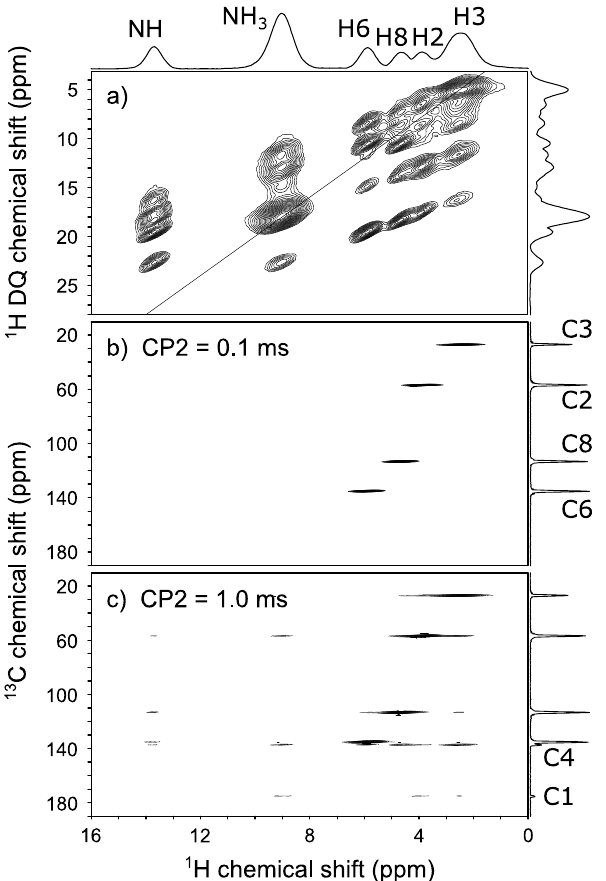
Figure 3. 1 H and 13 C spectral assignments of His with ( a ) 2D 1 H- 1 H R18 (cid:2872)(cid:2875) experiment, ( b ) and ( c ) 2D 1 H- 13 C proton-detected CP-HSQC experiments with ( b ) CP2 = 0.1 ms and ( c ) 1.0 ms. 1 H- 14 N PM-S-RESPDOR